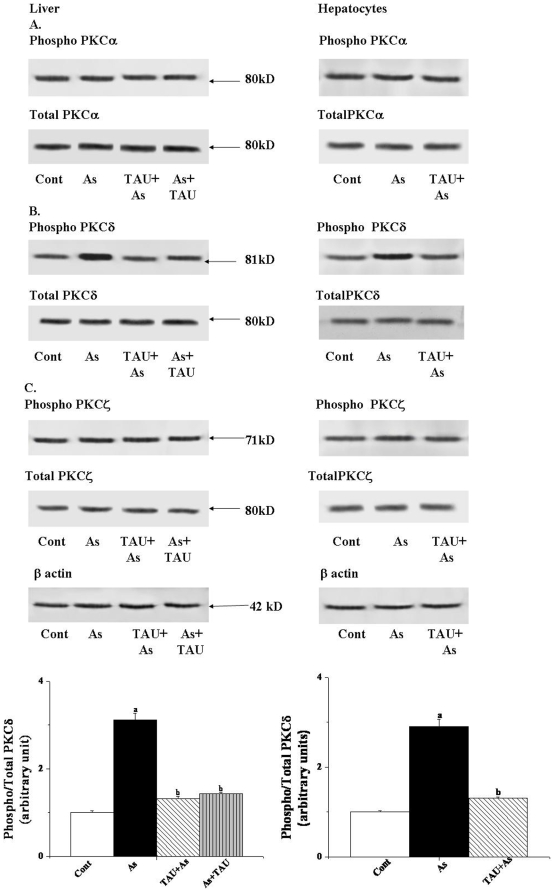
Immunoblot analysis of PKC family proteins in response to As and taurine (TAU+As and As+TAU).Panel A: Phospho and total PKCα, Panel B: Phospho and total PKCδ, Panel C: Phospho and total PKCξ. Data represent the average ± SD of 6 separate experiments in each group. β actin was used as an internal control. “a” indicates the significant difference between the normal control and As treated groups, “b” indicates the significant difference between the As treated and taurine treated groups. (Pa<0.05, Pb<0.05).